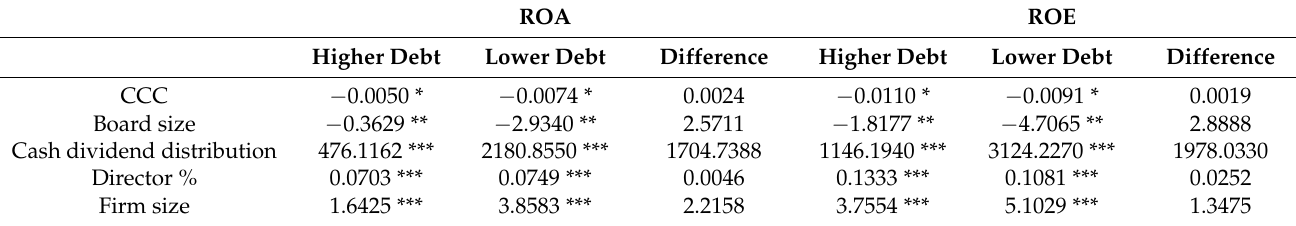
Table 4. Regression results after separate debt